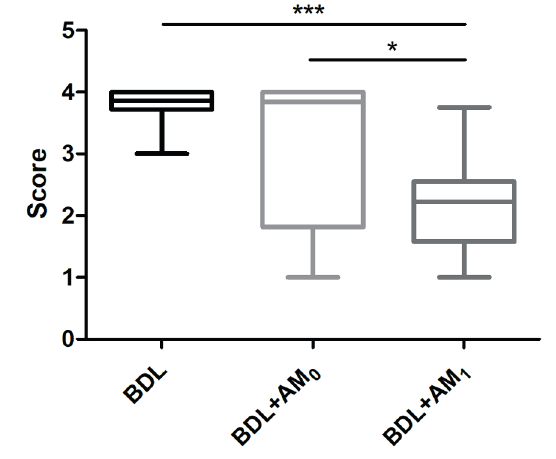
Figure 3 - Analysis of fibrosis degree by the Knodell classifi cation system. Median and interquartile range of fi brosis score in the experimental groups. * p <0.05 *** p